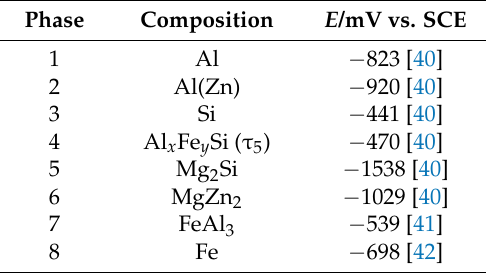
Figure 20. The fraction of Fe 4 Al 13 and Al 9 Fe 2 Si 2 phases. Table 5. Corrosion potentials of dross phase in related references